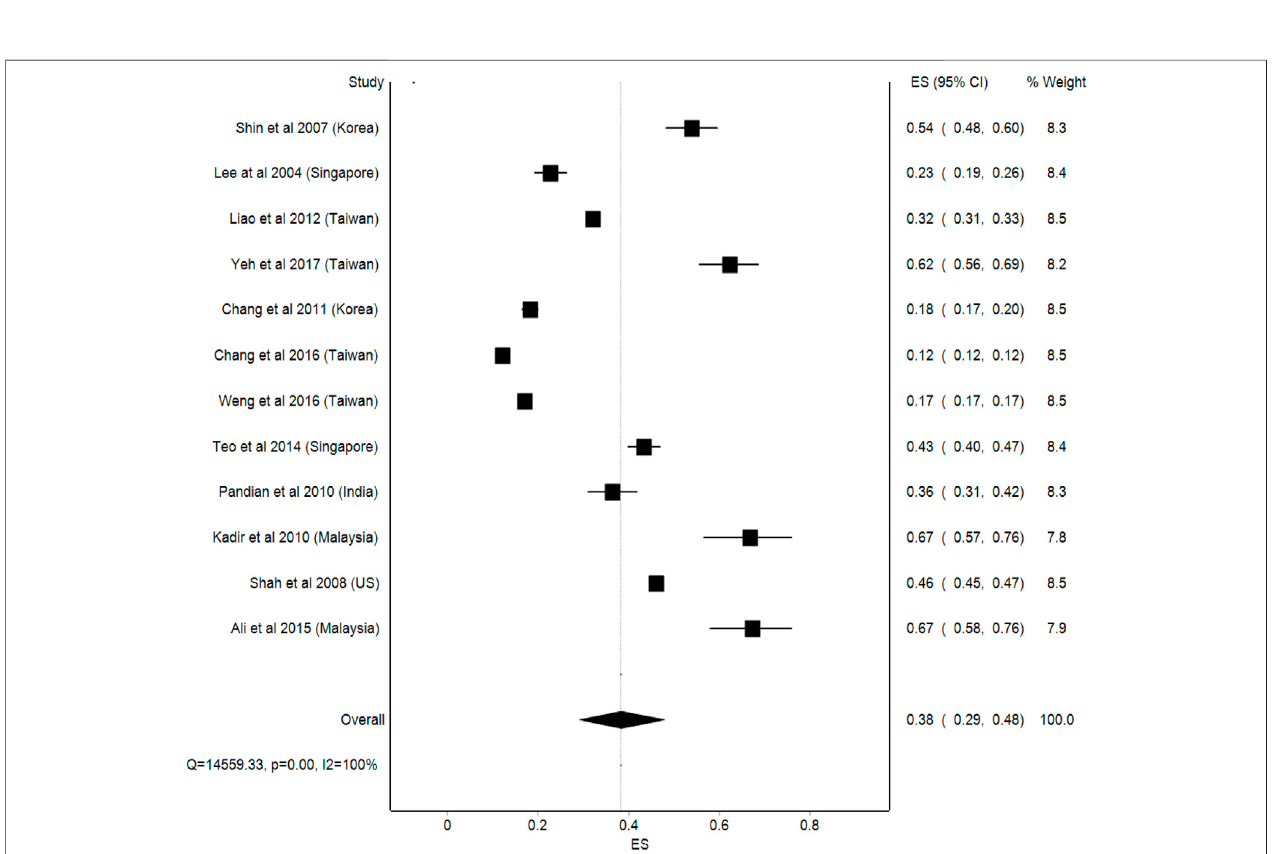
FIGURE 2 | Pooled prevalence of complementary and alternative medicine in stroke patients.